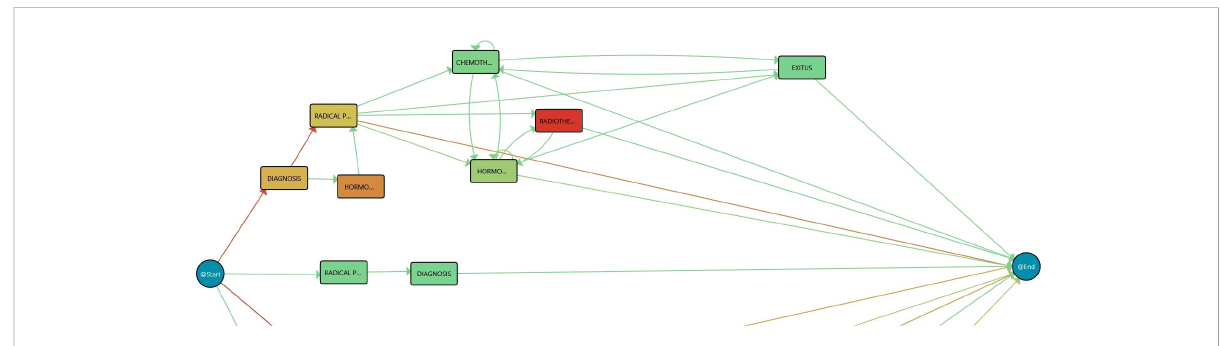
FIGURE 2 Process Mining rationale. Redder color in nodes, as opposed to green, represents higher time in that stage while redder color in transition means larger number of cases in that